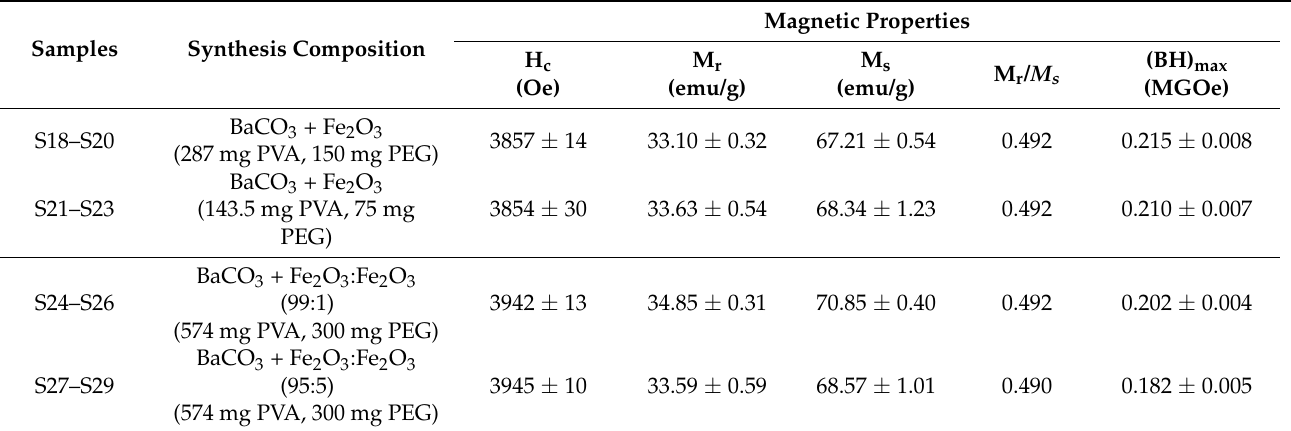
Table 2. Coercivity (H c ), remanent magnetization (M r ), saturation magnetization ( M s ), and maximum energy product ((BH) max ) of the hard/soft magnetic composites averaged from 3